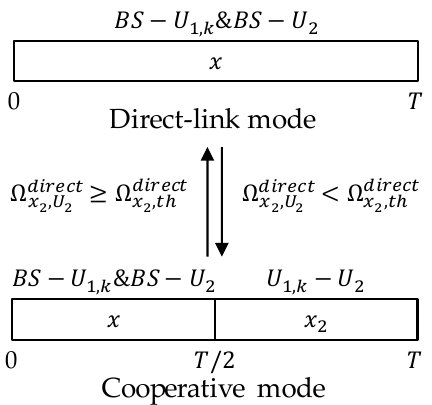
Figure 2. Time division resource allocation rule.